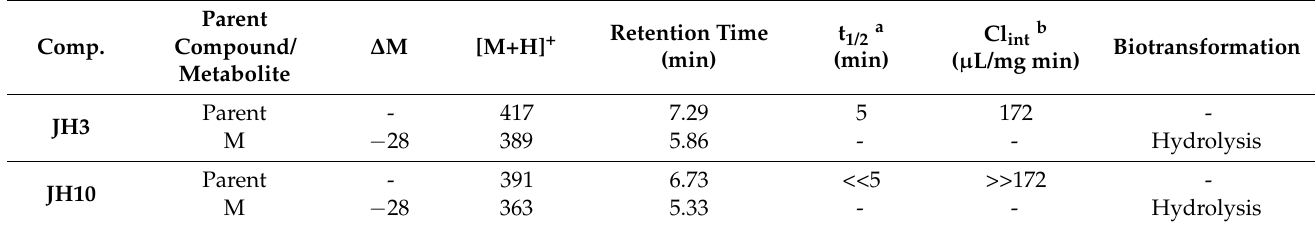
Figure 7. Plot demonstrating the depletion of JH3 in human liver microsomal system. Parent depletion expressed as natural logarithm of the percent remaining as peak area ratio (parent/internal standard). Table 5. Summary of data obtained for JH3 and JH10 and their ester hydrolysis products (M), generated in human liver microsomes